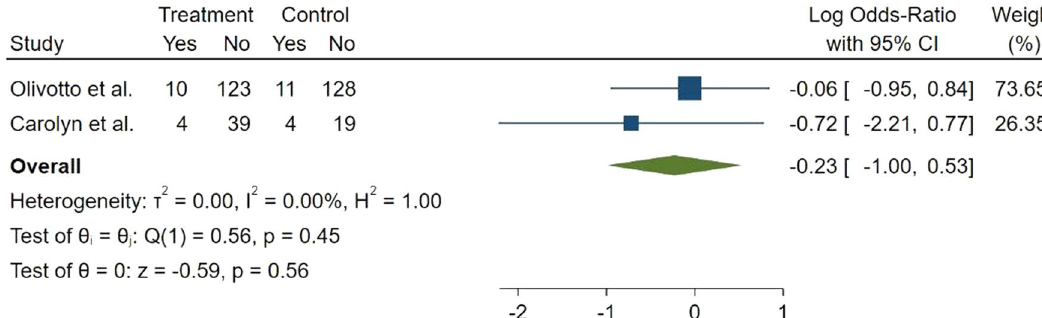
Fig. 6 Forest plot for serious adverse events